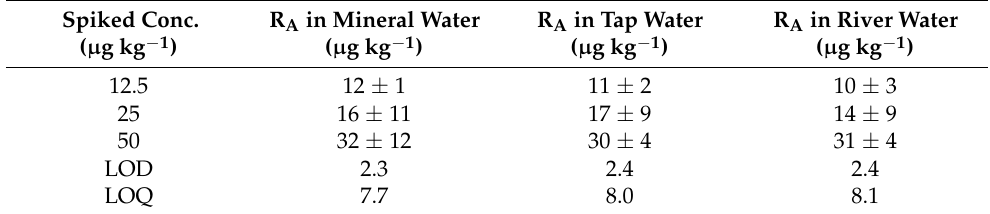
Table 1. LODs, LOQs, mean concentration levels and confidence levels (95%) for the analysis of ZON in water samples spiked at three different levels ( n = 3). Spiked